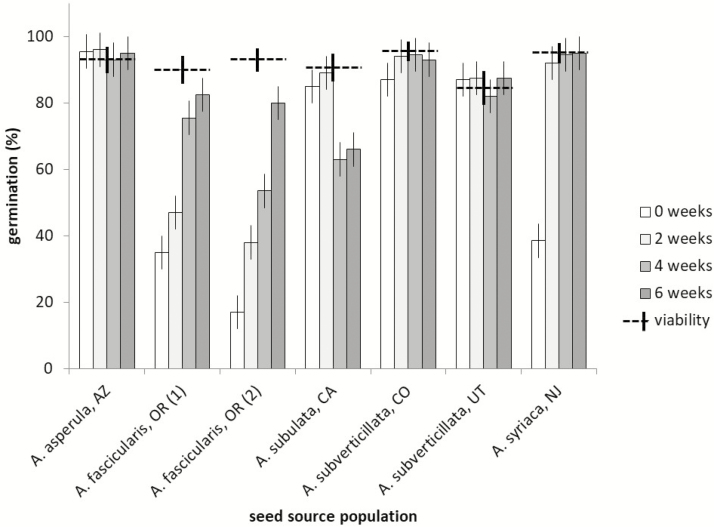
Seed germination in response to difference periods of cold stratification for five Asclepias species from the USA. Seed viability as estimated with TZ is shown with horizontal hatched lines. Error bars represent 95 % confidence intervals.